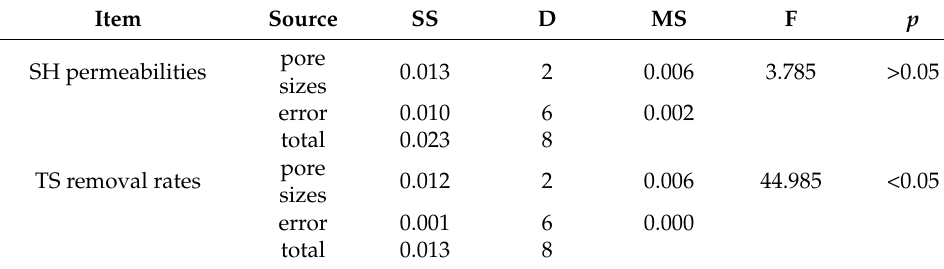
Table 3. ANOVA results of SH permeabilities and TS removal